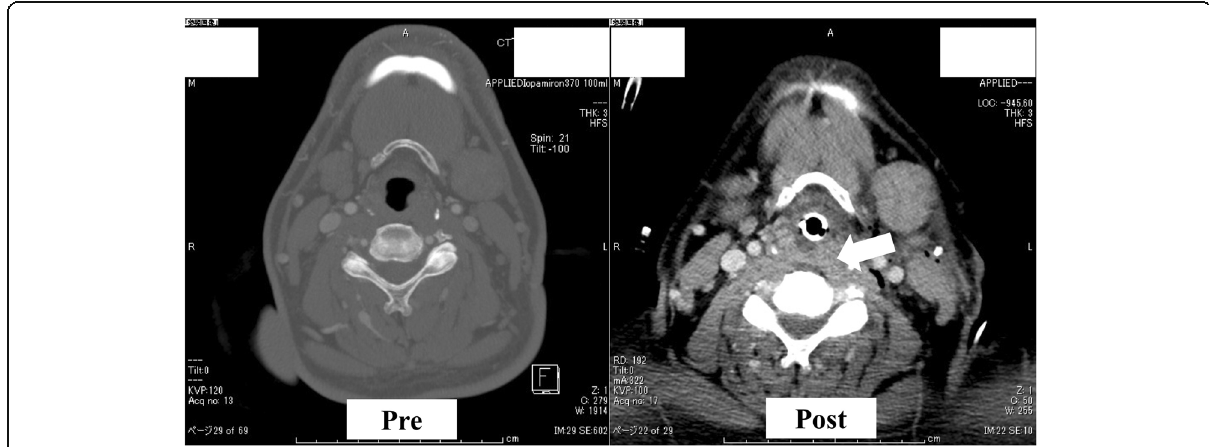
Fig. 3 Post-operative image of computed tomography scans shows the edema of the posterior pharyngeal wall was developed compared to the pre-operative